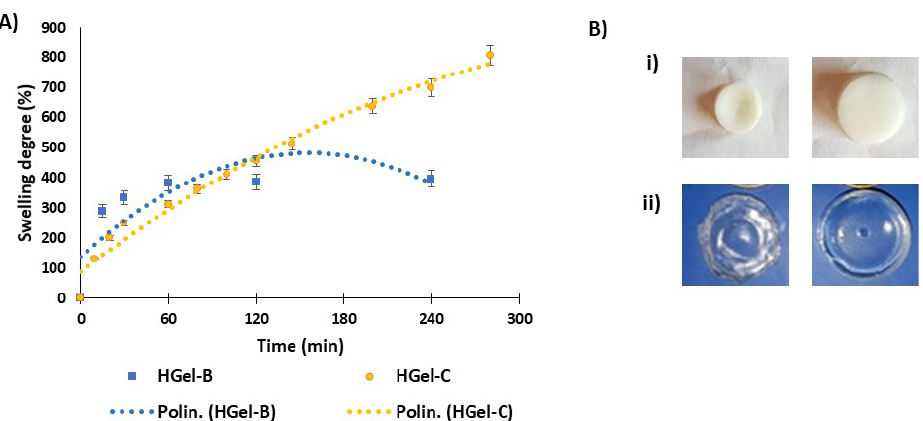
Figure 4. ( A ) Swelling degree over the time and ( B ) images (before and after swelling in water) of HGel-B (i) and HGel-C (ii). Reported are the mean ± SD values of three experiments and the polynomial regression that fits the data.